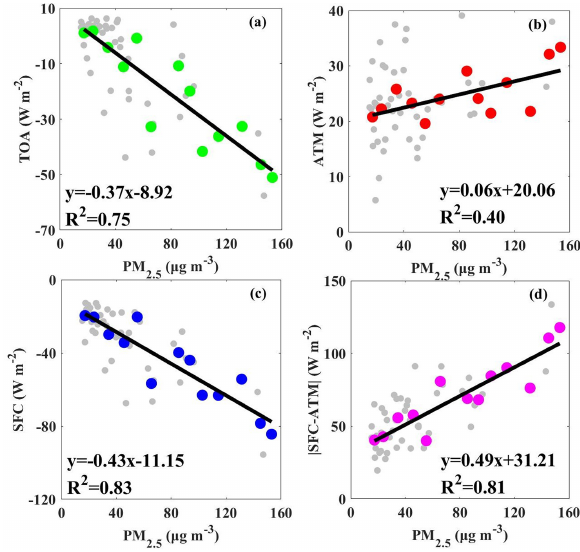
Figure 4. Scatterplots of the PM 2 . 5 mass concentration ( x ) ver- sus aerosol radiative forcing at the top of the atmospheric column (TOA; y ; a ); the interior of the atmospheric column (ATM; y ; b ); and the surface (SFC; y ; c ) as well as the absolute difference in SFC and ATM ( | SFC − ATM | ; y ; d ), respectively (gray dots: daily data; other dots: mean data). (The daily data mean daily mean val- ues of TOA, ATM, SFC and corresponding daily averaged PM 2 . 5 mass concentration from 27 November 2018 to 25 January 2019 in Beijing. The mean PM 2 . 5 concentrations were obtained by av- eraging daily PM 2 . 5 concentrations at intervals of 10µgm − 3 . The mean TOA, ATM and SFC were obtained after the corresponding daily TOA, ATM and SFC average, respectively. For example, all daily PM 2 . 5 concentrations greater than 40µgm − 3 and less than 50µgm − 3 were averaged as a mean PM 2 . 5 concentration, and TOA values (ATM, SFC) corresponding to this daily PM 2 . 5 concentration range were also averaged as a mean TOA (ATM,